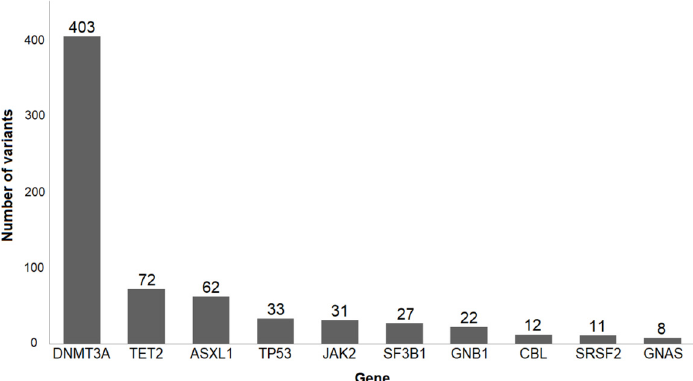
Figure 1. 10 most frequently mutated genes implicated in hematologic cancers (modified from [11]). 693 samples were investigated. 693 samples were investigated.